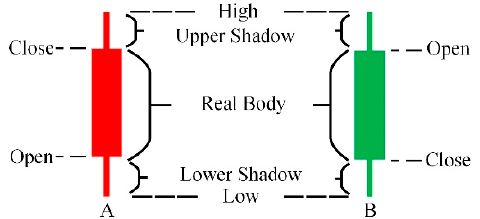
Figure 1. Schematic diagram of Japanese Candlestick.